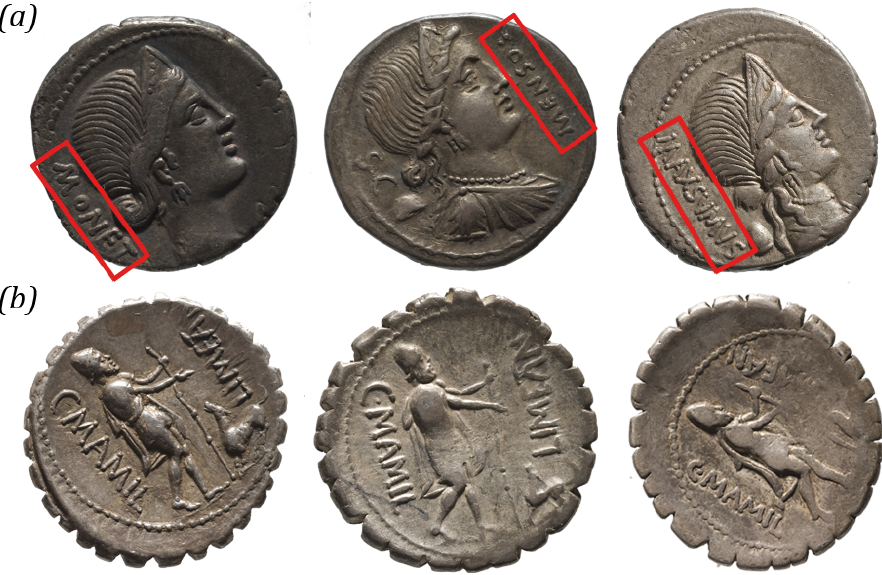
Figure 1: Examples of Roman Republican coins. (a) Low inter-class variability. Three coins of different classes that only differ in their legend. (b) High intra-class variability. Three coins of the same class that show little